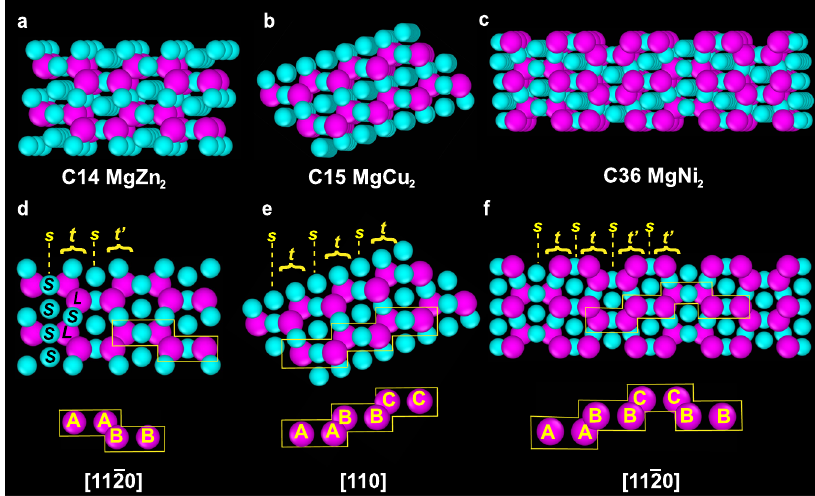
Fig. 1 Binary Laves crystal structures. 3D views of the ( a ) C14 (MgZn 2 ), ( b ) C15 (MgCu 2 ) and ( c ) C36 (MgNi 2 ) structures. ( d ) C14 structure viewed along the [11 (cid:1) 20] projection. ( e ) C15 structure viewed along the [110] projection. f C36 structure viewed along the [11 (cid:1) 20] projection. For interactive 3D views of the three Laves phases, see Supplementary Data 1 –